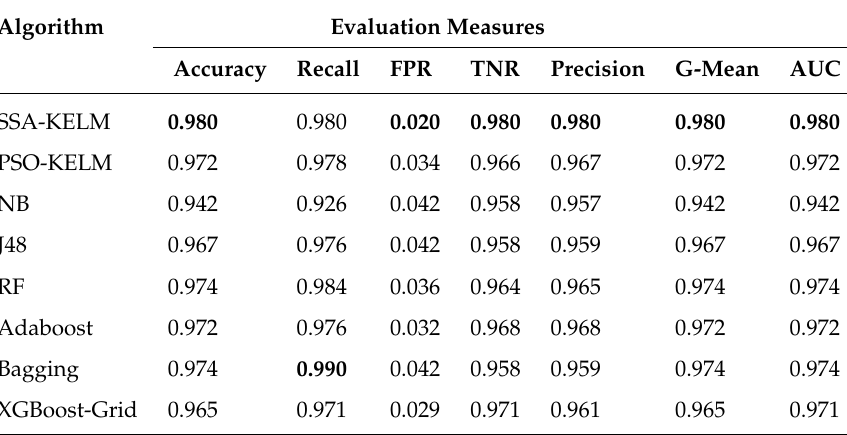
Table 7. Comparison of the performance of the SSA-KELM with conventional machine learning algorithms in terms of various evaluation